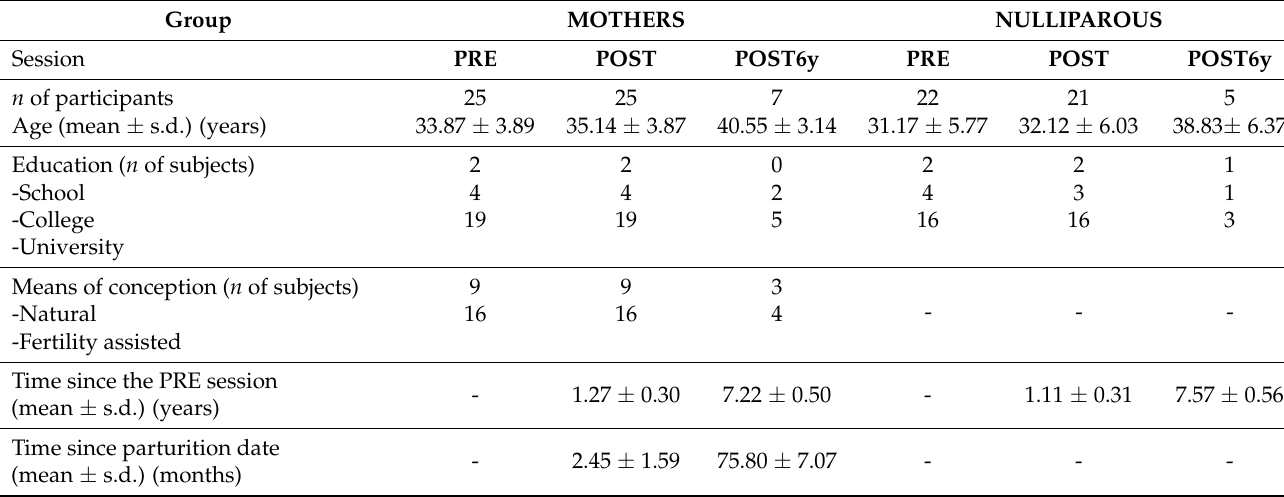
Table 1. Demographic characteristics of the